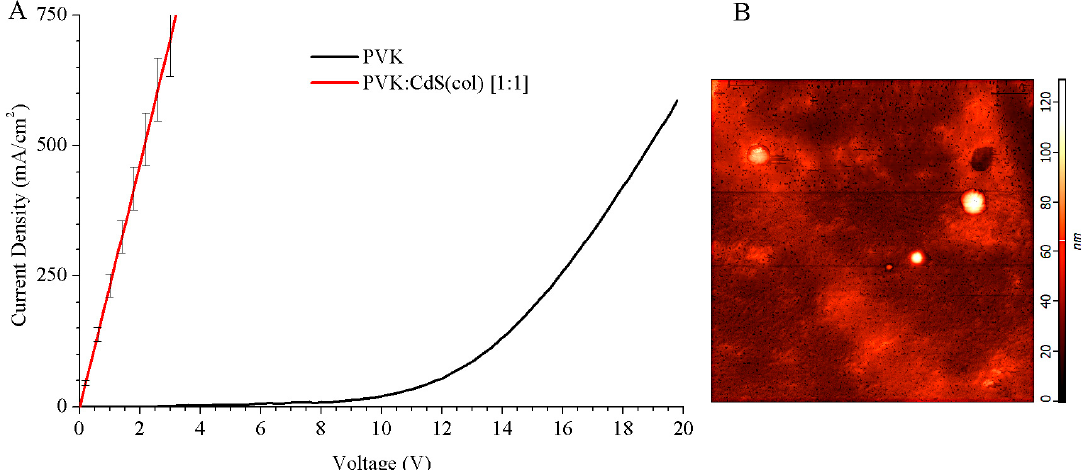
Figure 4. J–V curves of the OLEDs ( A ) and atomic force microscopy (AFM) image (area of 10 µ m × 10 µ m) ( B ) corresponding to the hybrid LED with PVK:CdS(col) active layer. The color scale on the right indicates surface roughness.